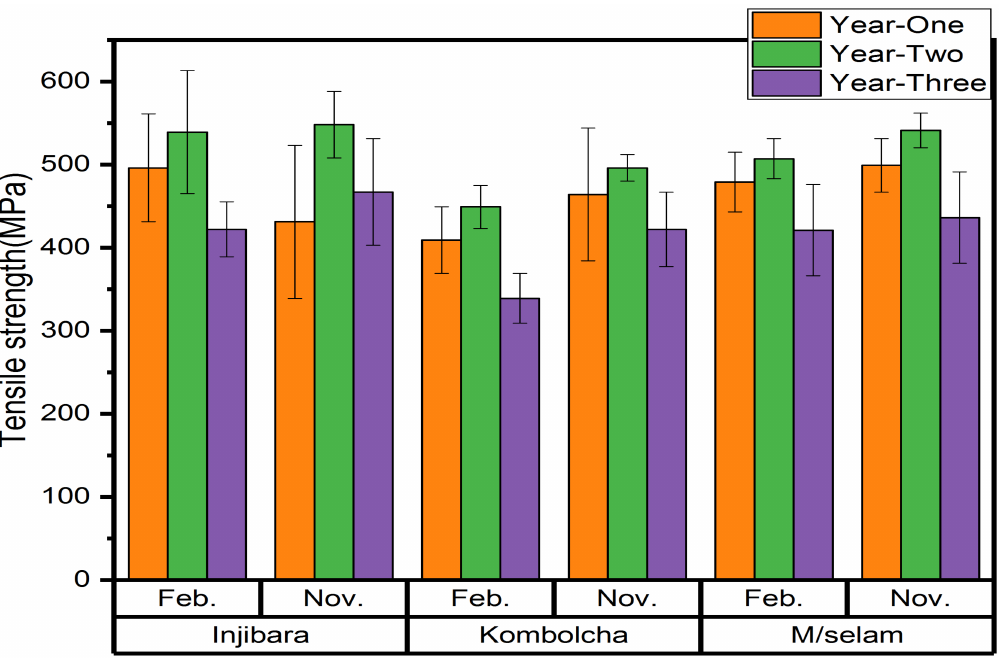
Figure 5. Back-calculated tensile strength of Ethiopian bamboo fibres using